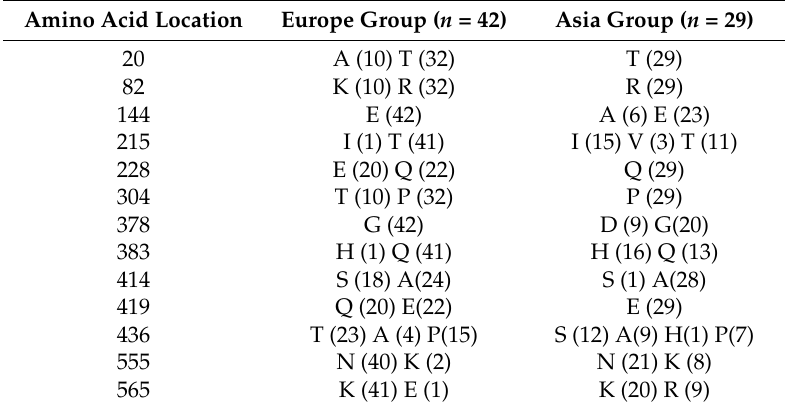
Table 2. Distinct amino acid regions in VP 2 in European and Asian strains.